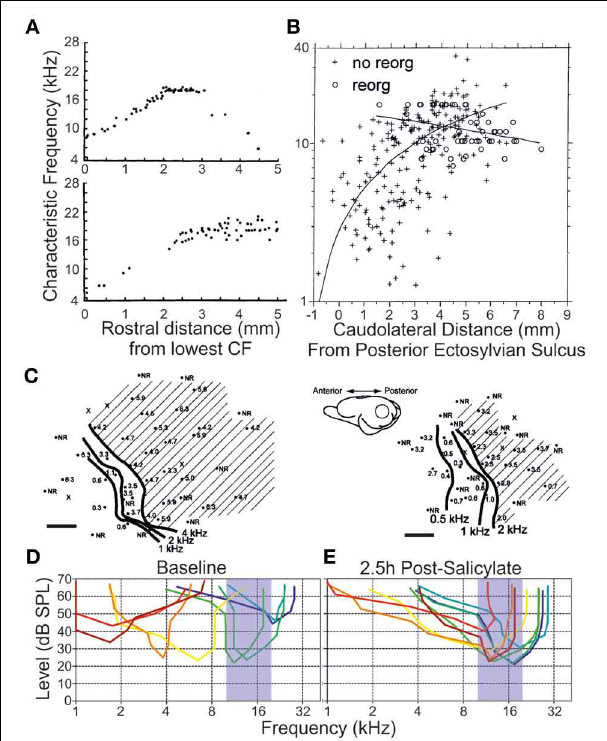
FIGURE 5 | Remapping of the tonotopy in the primary auditory cortex following a variety of peripheral insults. (A) A flattening of the linear progression of characteristic frequency (CF) tuning when units were recorded along the dorsoventral axis of primary auditory cortex is observed following partial mechanical lesion of the cochlea in adult cats (individual subjects, upper and lower. Each datapoint represents a single unit CF. Modified with permission from Rajan et al. (1993). (B) A similar flattening of tonotopic progression is demonstrated as a function of distance along the cortical surface dorsoventrally in adult cats exposed to narrowband-passed acoustic trauma (crosses), compared with naive controls (circles). Modified with permission from Seki and Eggermont (2002). (C) In individual adult chinchillas (left, right) exposed to amikacin-induced basal cochlear hair cell lesions, there is a rearrangement of cortical responses to preference low characteristic frequency responses at regions of the cortex normally responsive at threshold to higher frequency stimuli (shaded region). Scale bars 1mm. Modified with permission from Kakigi et al. (2000). (D) When individual multiunits were isolated in the adult rat primary auditory cortex (each unit is a different color), together spanning the hearing range of the animal, (E) systemic injection of salicylate (250mg/kg intraperitoneal) produced a dynamic retuning of multiunits toward a CF range of 10–20kHz by 2.5h after injection. Modified with permission from Stolzberg et al.